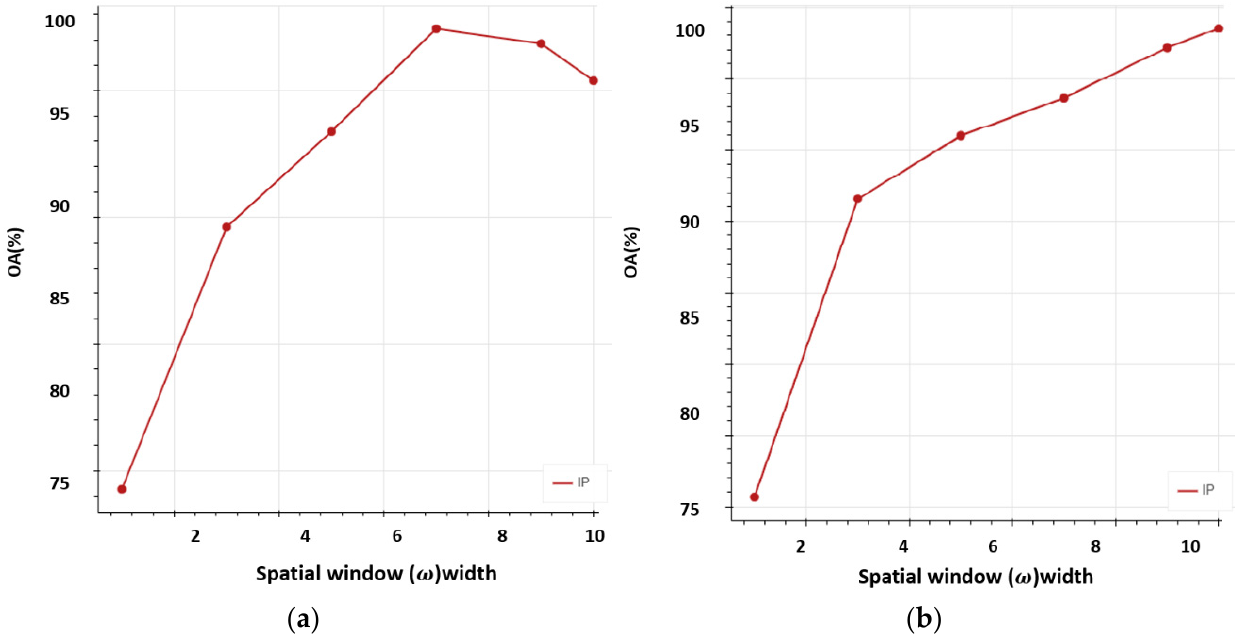
Figure 11. Shows the overall accuracy (OA%) vs. spatial window ( ω ) width: ( a ) 5% training samples; ( b ) 10% training samples.